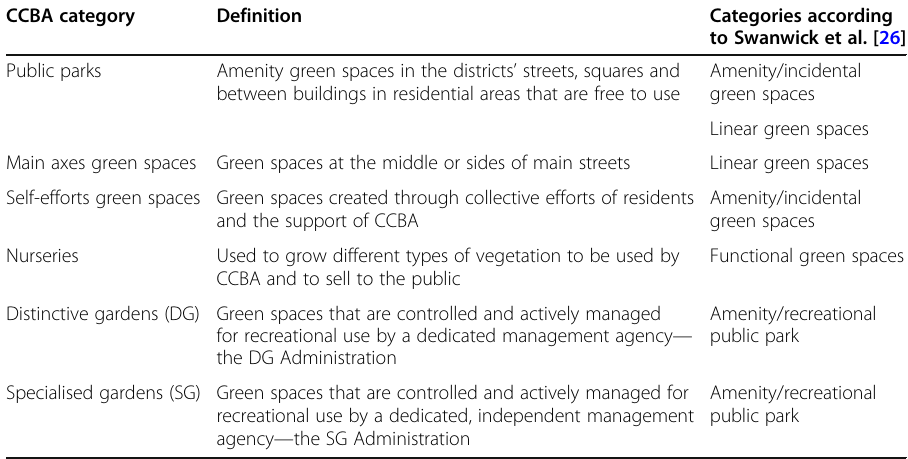
Table 1 CCBA Categorisation for green spaces and equivalent category in literature CCBA